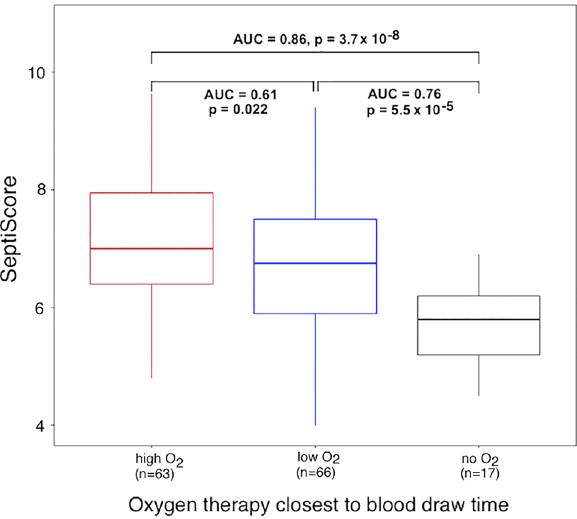
Figure 5. SeptiScore stratified by type of oxygen therapy closest to blood draw. A total of 146 patients are represented in this